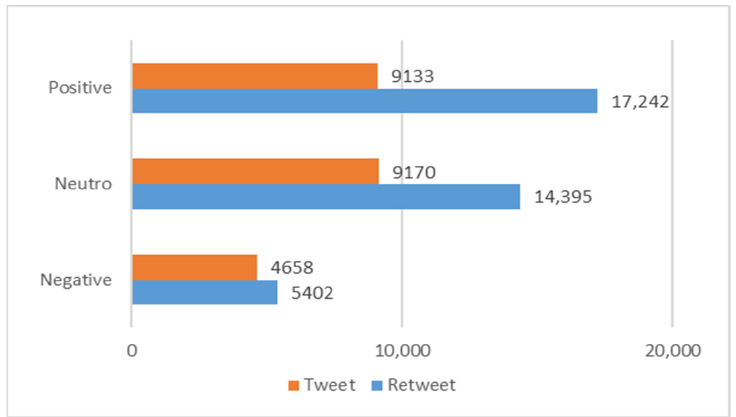
Figure 12. Daily evolution of emotions.